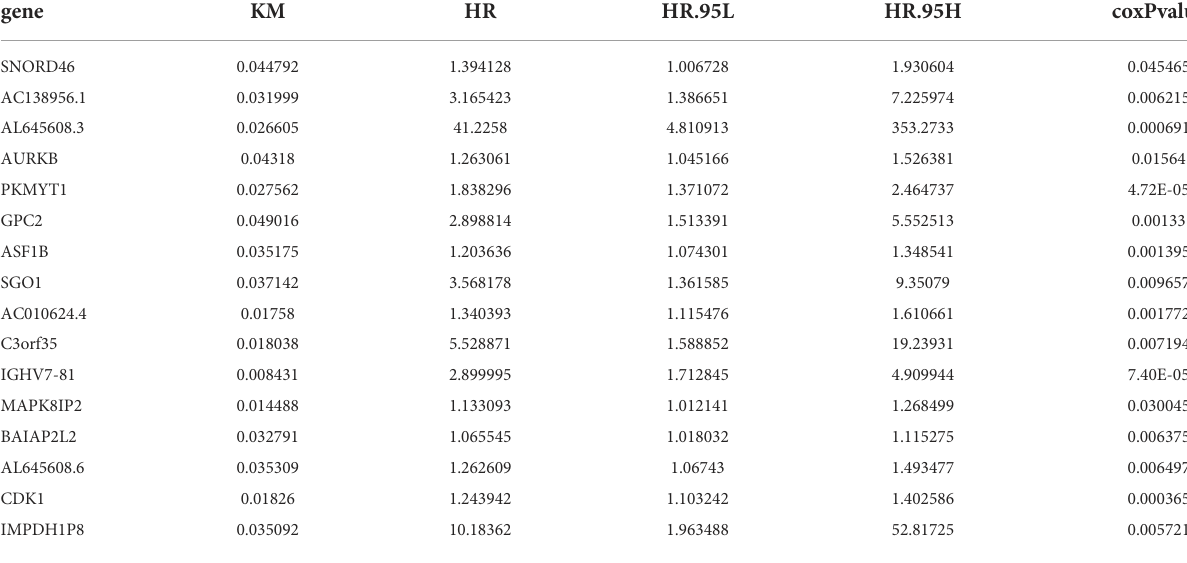
TABLE 1 41 genes that were signi fi cantly differentially expressed between PRAD tissue and normal prostate